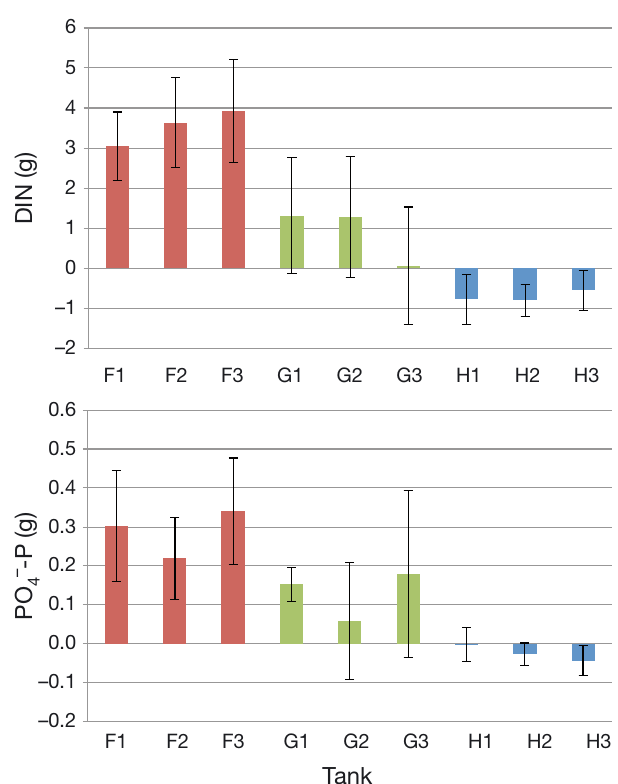
Fig. 4. Average (±SD) change in total dissolved inorganic ni- trogen (DIN) and PO 4 -P in the individual tanks (F: fish; G: sea cucumber; H: halophyte) of the RAS (n = 3), after periods of interrupted water circulation during the 70 d experiment